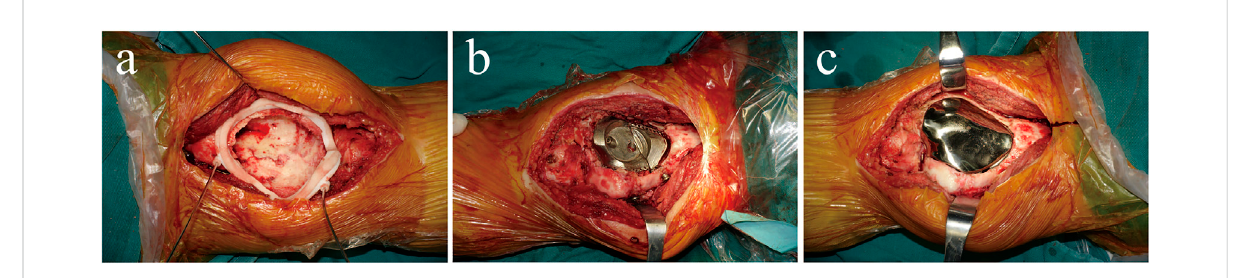
FIGURE 4 (A) The circular 3D-printed guided plate is fi xed on the bone margin of the tumour. (B) The back components are inserted into the bone cavity and fi rmly fi xed to the surrounding bone with four screws. (C) The front component is fi rmly fi xed on the back components through a press- fi t structure and conforms to the surrounding articular surface.